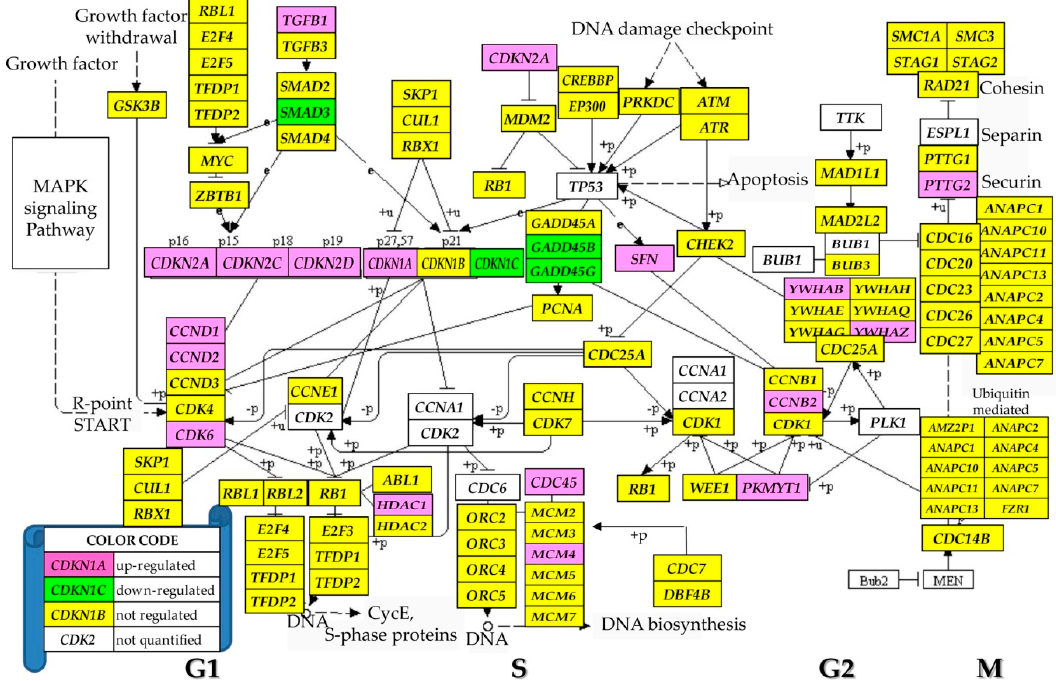
Figure 4. Regulation of the KEGG-determined cell cycle (hsa04110). Regulated genes: cyclins ( CCNB2/D1/D2 ), cell division cycle 45 ( CDC45 ), cyclin-dependent kinase inhibitors ( CDKN1A/1C/2A/2C/2D ), growth arrest and DNA-damage-inducibles ( GADD45B/D ), histone deacetylase 1 ( HDAC1 ), minichromosome maintenance complex component 4 ( MCM4 ), membrane associated tyrosine/threonine 1 ( PKMYT1 ), pituitary tumor-transforming 2 ( PTTG2 ), stratifin ( SFN ), SMAD family member 3 ( SMAD3 ), transforming growth factor, β 1 ( TGFB1 ) and tyrosine 3-